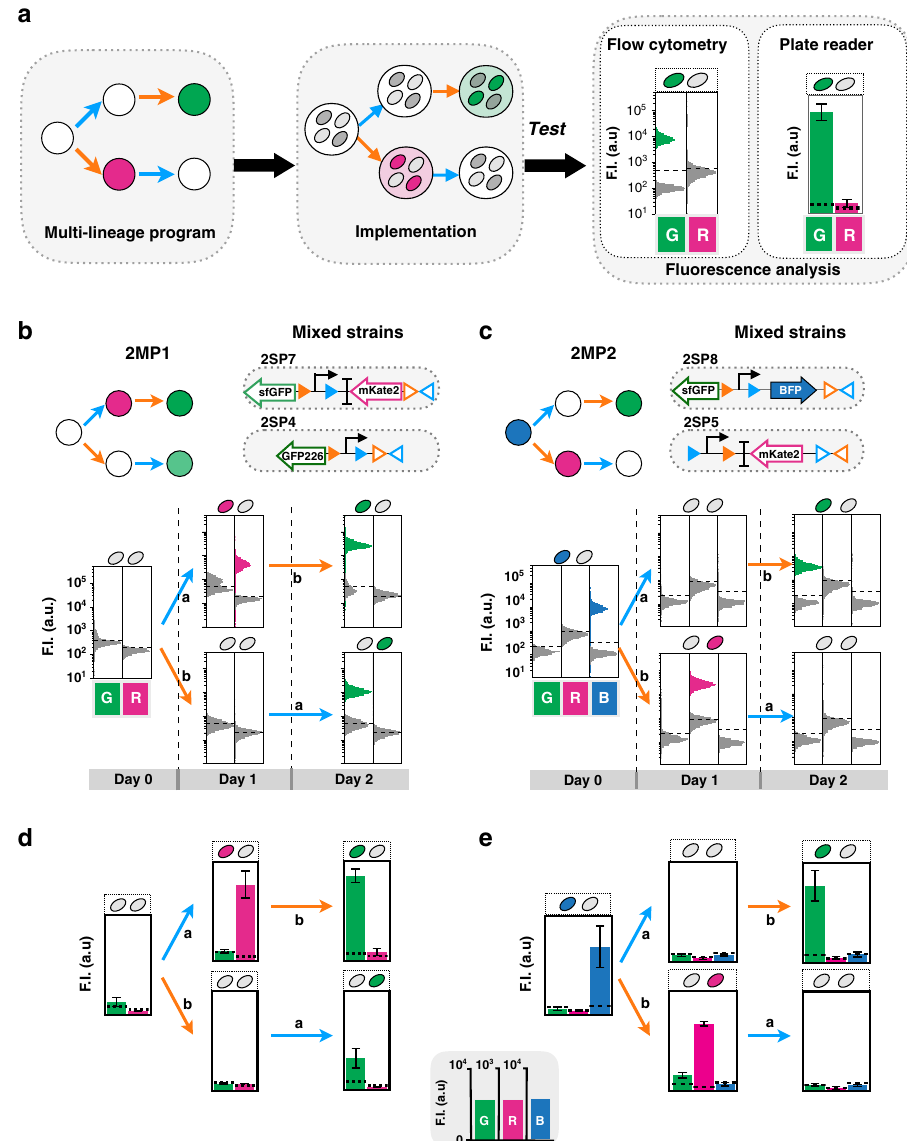
Fig. 3 Characterization of 2-input multicellular programs. Work fl ow characterization of 2-input multicellular programs ( a ). After the input program design, single-lineage programs are mixed and the multicellular program is implemented. The program characterization is done by fl uorescence measurements by fl ow cytometry and plate reader. The fl ow-cytometry analysis allows us to observe the percentage of population ON and OFF for one state. Design and characterization of 2-input multicellular program 2MP1 and 2MP2, by fl ow cytometry ( b , c ) and plate reader ( d , e ), respectively. Both multicellular programs were implemented using two different single-lineage strains. The lineage trees for each program and its corresponding genetic DNA device are represented. The inputs are represented by letters, a for aTc inducing Bxb1 Integrase and b for arabinose inducing Tp901-1 integrase. To implement each program, the strains were mixed in similar proportions, grown for 16 h and sequentially induced with each molecule. Each histogram shows the expression of fl uorescent reporters at different induction states. A representative example is depicted here. The bar graph corresponds to the mean value of the fl uorescence intensity (F.I.) in arbitrary units (a.u) for each fl uorescent channel (G (GFP), R (RFP), and B (BFP)) with linear different scales. All experiments were performed in triplicate three times on 3 different days (data distribution in dot plots in Fig. S7c – f). The error bars correspond to the ±standard deviation of the mean of the three different experiments. The dotted line indicates the negative auto fl uorescence from control strain. Note that GFP226 has a lower fl uorescence intensity than sfGFP, as